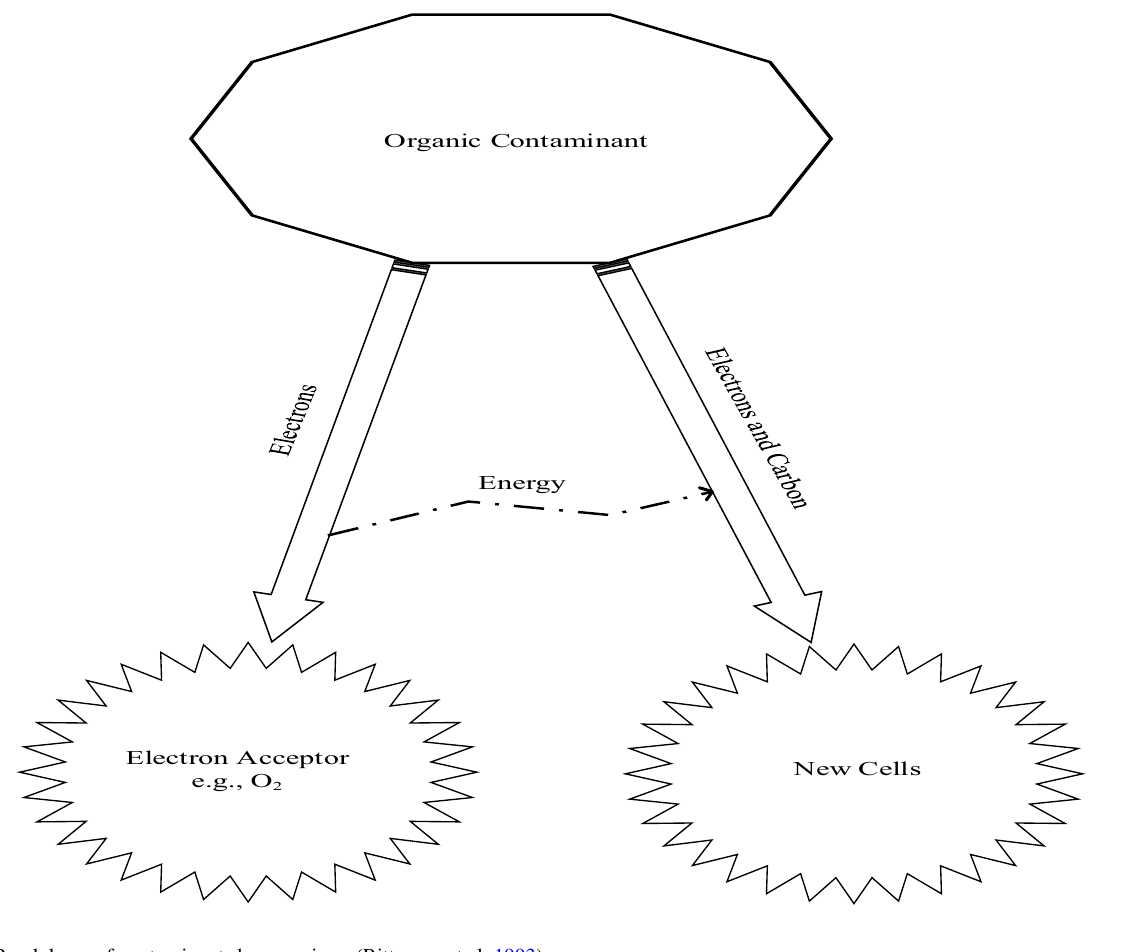
Fig. 6 Breakdown of contaminants by organisms (Rittmann et al.